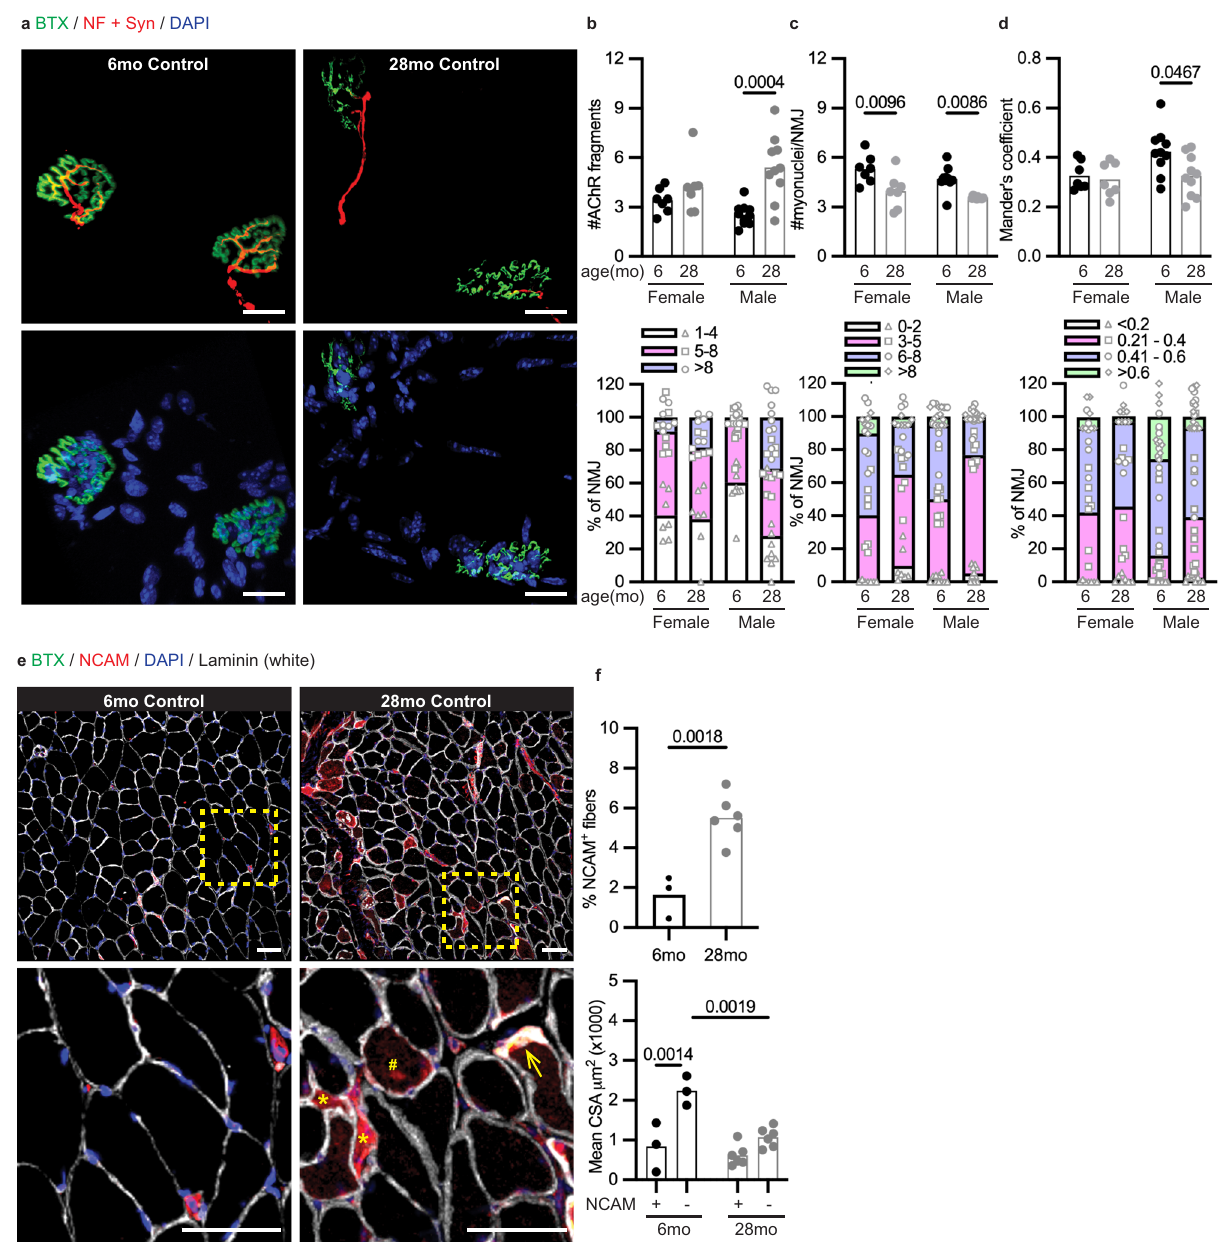
Fig. 1 | Sexual dimorphism of NMJ remodeling during aging. a Representative confocal images of NMJs from longitudinal sections of the quadricep muscle of 6- and 28-month-old male control mice (6mo Control and 28mo Control, n =10 per group). Top panels=BTX (green) and neuro fi lament (NF; red) + synaptophysin (Syn; red); Bottom panels=BTX (green) and DAPI (blue). Scale bar=20 μ m. b – d Quanti fi cation of NMJ morphological properties of male and female control mice, which include ( b ) the number of AChR fragments, ( c ) the number of post- synaptic myonuclei, and ( d ) the overlap between pre- and post-synaptic compo- nents as measured by the Mander ’ s colocalization coef fi cient. The top fi gures are meanvaluesperanimalandthebottom fi guresarepercentagedistributionforeach parameter. Sample size: 6mo Control Female and 28mo Control Female, n =7 per group;6moControlMaleand 28moControlMale, n =10pergroup;onaverage,25 NMJs were analyzed per mouse. e Representative confocal images of BTX (green), of pS6-positive fi bers from TSC1mKO mice ( P = 0.006; Fig. 2b) was larger than that of control mice. Next, we analyzed the NMJs of these mice at 12 months old to determine age-related abnormalities. This timepoint was chosen because TSC1mKO mice showed advanced myopathy 17,18 .